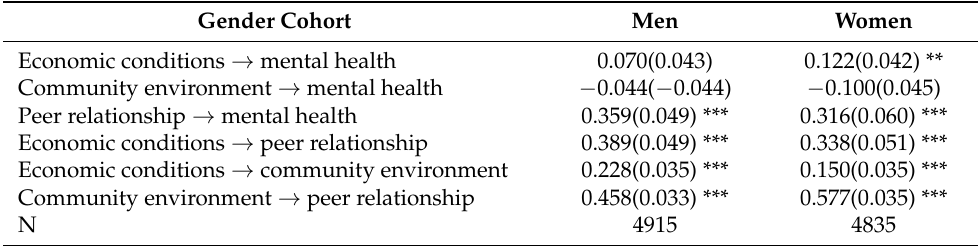
Table 5. Multi-group comparison by